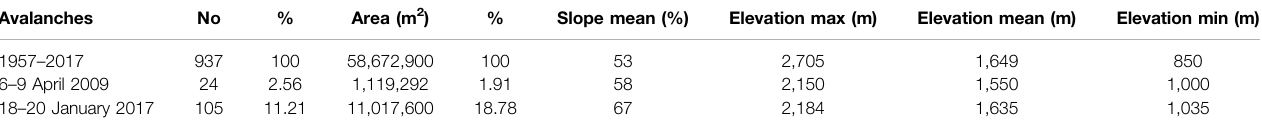
TABLE 6 | Distribution and average morphometry of the avalanches on April 6 – 9, 2009, January 18 – 20, 2017, and from 1957 to 2016. Avalanches